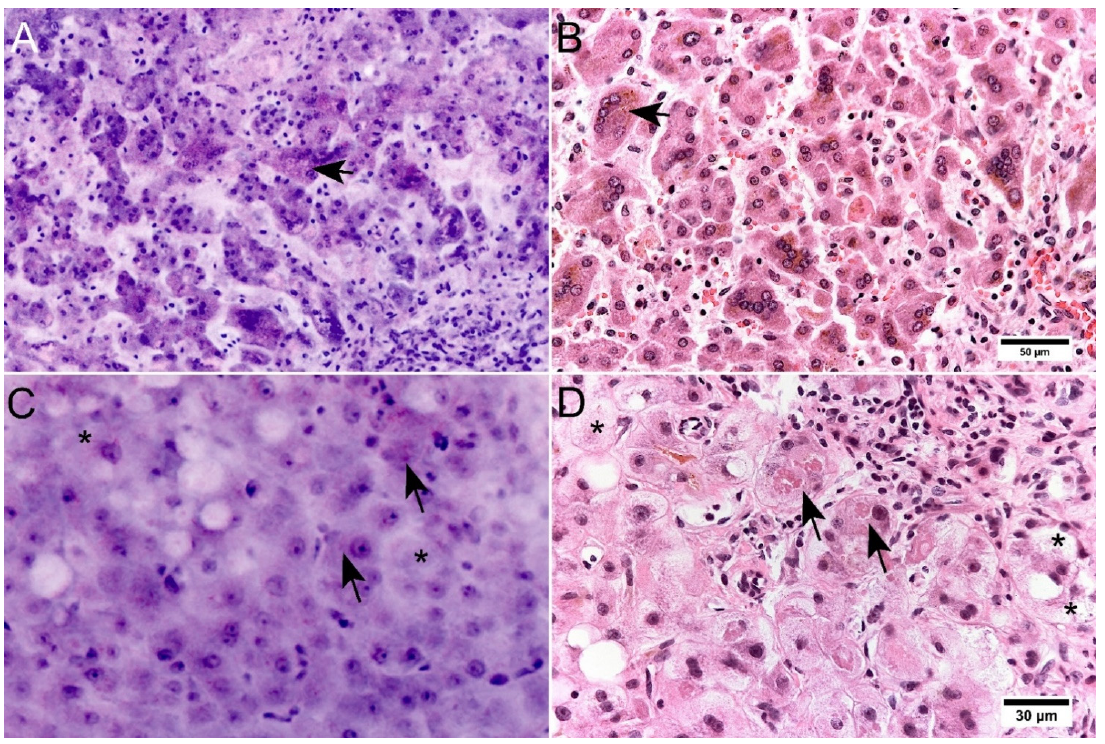
Figure 6. Limited representation of cytoplasmatic changes in FCM scans. ( A , B ): Neonatal giant cell hepatitis in FCM ( A ) and conventional histology (( B ), HE staining). FCM scans show a marked lobular inflammatory infiltrate and trabeculae of multi-nucleated hepatocytes. Note the discrepancy in the presentation of cytoplasmic bile accumulation. In FCM, cytoplasmatic accumulation of bile (arrows) does not give a signal and is only represented as empty cytoplasmic vacuoles. ( C , D ): A Case with alcoholic steatohepatitis in FCM ( C ) and conventional histology (( D ), HE staining). Macrovesicular steatosis is very well represented in FCM scans of native liver tissue. Ballooning degeneration (asterisks) and Mallory bodies (arrows), that are clearly visible in the HE-slides, are very subtle in FCM scans and were missed by the blind assessment. There is also no correlate for canalicular bile stasis visible in the HE-slide.